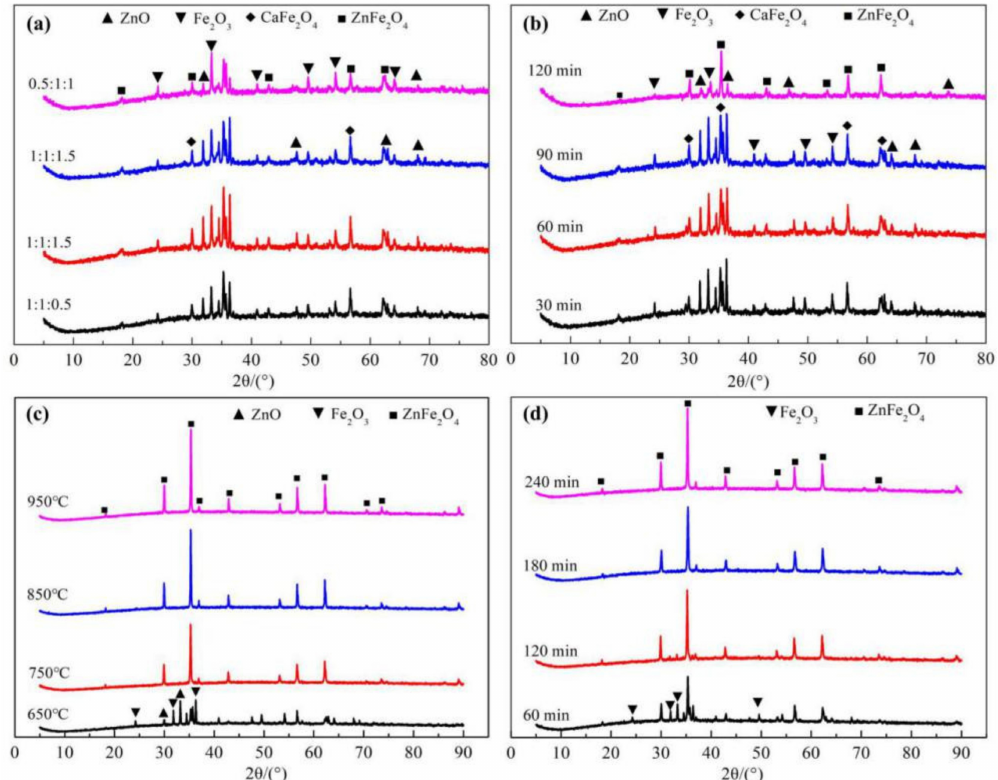
Figure 4. XRD patterns of roasted products under different conditions: ( a ) different ratio; ( b ) activation time; ( c ) roasting temperature; ( d ) roasting